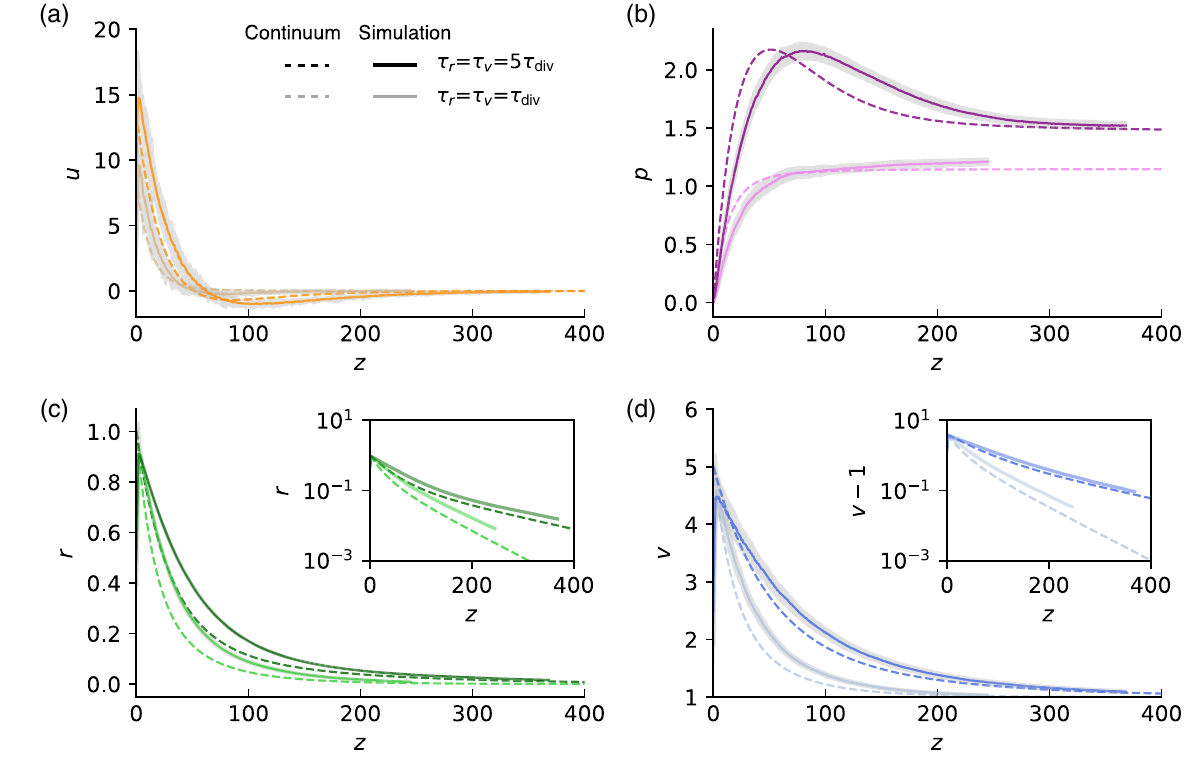
FIG. 4. The mechanochemical variables exhibit different profiles behind the moving growing front with the simulations and continuum theory in semiquantitative agreement. Shown are steady-state average values of (a) lab-frame cell velocity u , (b) local cell pressure p , (c) cell-cycle activity r , and (d) 2D cell volume (area) v , measured a distance z behind the leading edge of the growing colony. The solid lines are from particle-based simulations with τ deviation shown in gray). The dashed lines show the continuum solution. Insets in (c) and (d) reveal exponential decay deep in the bulk using a log-linear scale; see Appendix B 2 for an analysis of these